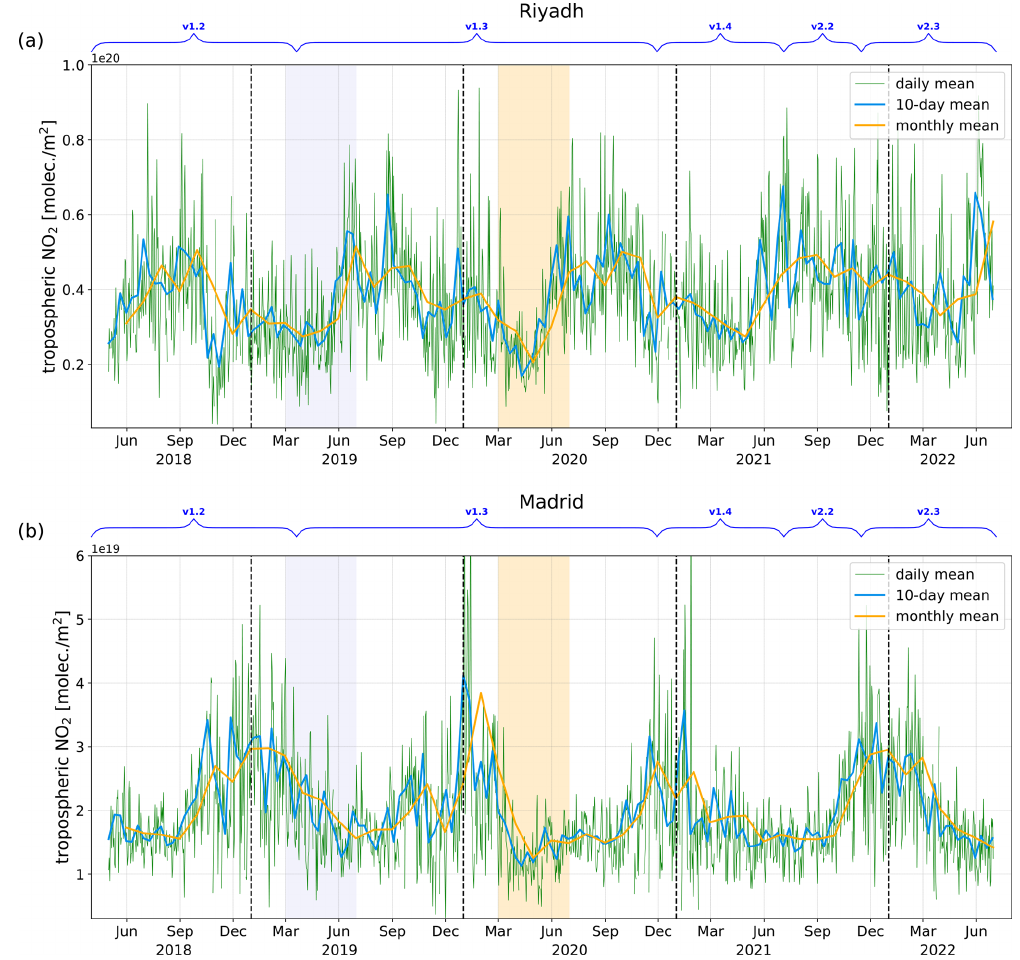
Figure A12. Time series of TROPOMI tropospheric NO 2 columns in terms of the daily, 10d, and monthly mean in (a) Riyadh and (b) Madrid. The areas marked using lavender and orange colors are the study periods in 2019 and 2020, respectively. The annotations on top of each panel represent the different versions of data